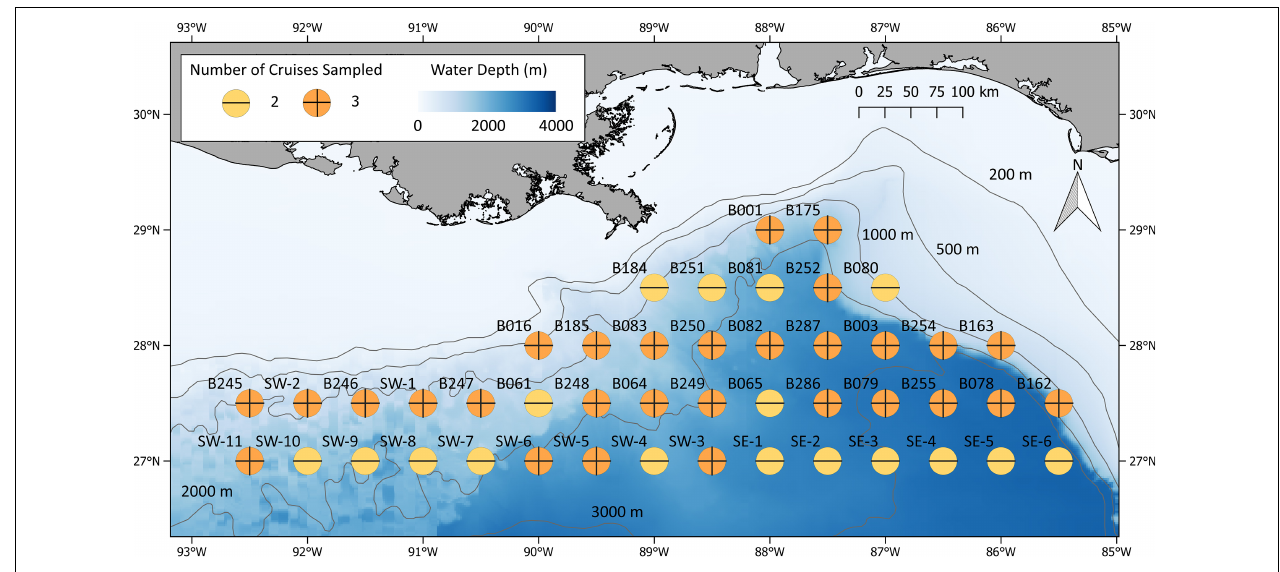
FIGURE 1 | ONSAP MOC10 stations sampled during the winter, spring, and summer 2011. Symbol colors represent the number of seasons (up to three) each location was sampled.